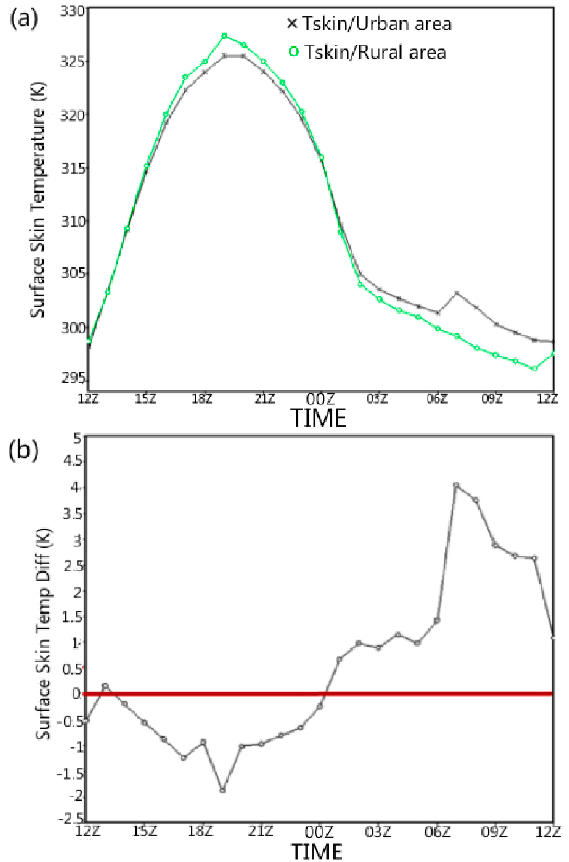
Figure 13. ( a ) The WRF/SLUCM-simulated T skin (urban vs. rural) in OKC, with the green curve representing the T skin over the OKC urban area, and the black curve representing the T skin over its rural area; ( b ) The SLUCM-simulated T skin difference (urban–rural) in OKC. Temperature and temperature difference is in